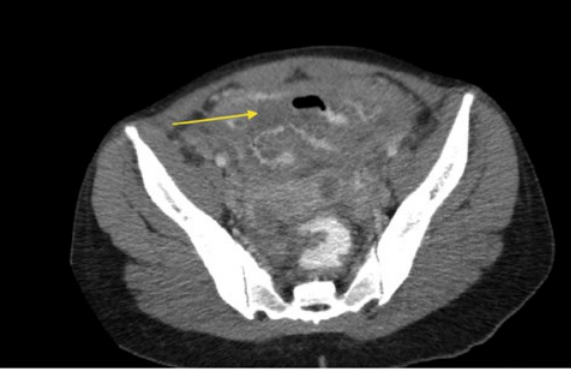
Figure 6e: Axial post-contrast CT abdomen showing markedly thickened small bowel loops (arrow) in a known patient with